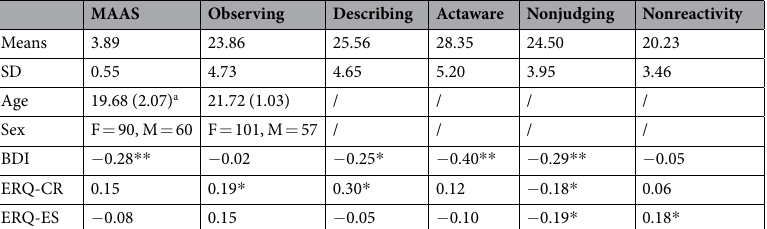
Table 1. Demographics and psychometric measures. SD = standard deviation; BDI = Beck Depression Inventory; ERQ-CR = Cognitive Reappraisal dimension of Emotion Regulation Questionnaire; ERQ-ES = Expressive Suppression dimension of Emotion Regulation Questionnaire. Pearson bivariate correlations, where the r-values are shown; a mean ± SD; * P < 0.05; ** P < 0.001.